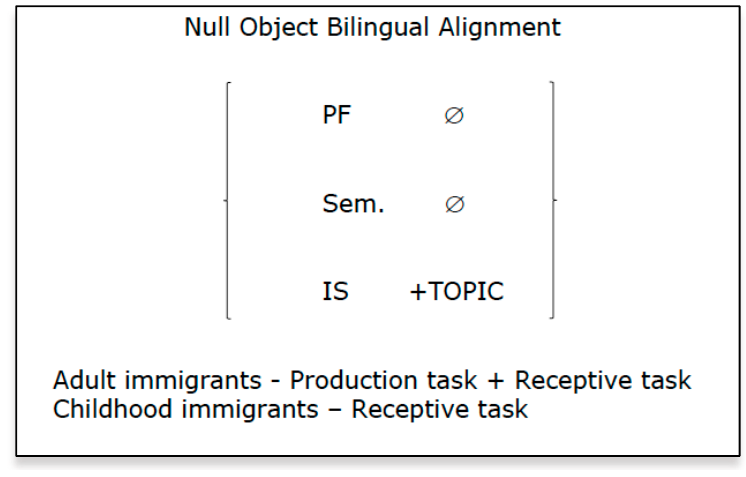
Figure 7. Null object bilingual alignments.